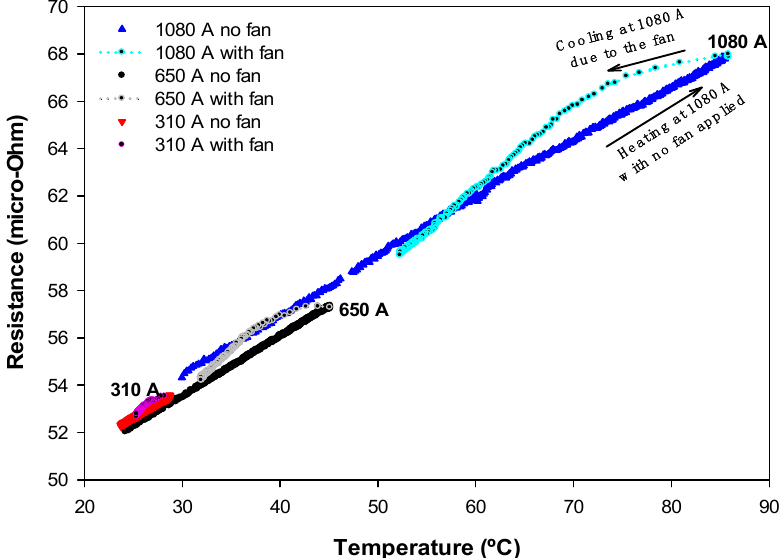
Figure 6. Three-layer ACSR conductor. R ac versus temperature measured for heating-cooling cycles at 1080 A, 650 A and 310 A.